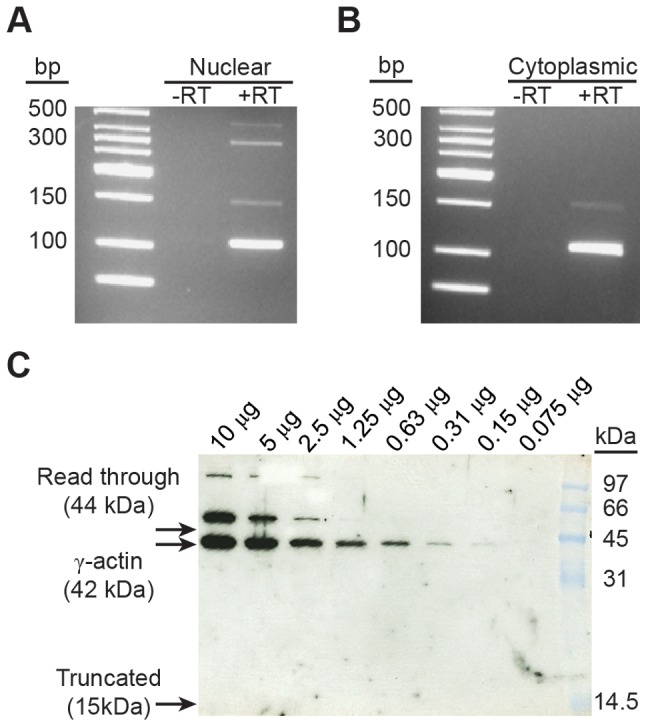
Exon 3a containing alternatively spliced Actg1 is exported to the cytoplasm, but does not produce a stable protein.Nuclear (A) and cytoplasmic (B) RNA fractions were harvested from C2C12 myotubes and evaluated for the presence of alternative Actg1 using competitive, end-point PCR. All Actg1 spliceforms, including partially spliced transcripts, were present in the nuclear fraction, however, only the normal and exon 3a transcripts were observed in the cytoplasmic fraction. (C) Western blot using an anti-γ-actin specific antibody was used to probe mouse skeletal muscle lysate for the presence of a protein product corresponding to the inclusion of exon 3a. Usage of the in-frame stop codon in exon 3a would generate a 15 kDa protein. Alternatively, read-through of the stop codon would increase the size of the ACTG1 protein by 2 kDa, resulting in a 44 kDa protein. Neither of these protein products is present. A γ-actin protein at 52 kDa is observed and likely represents a post-translational modification. Molecular weight marker is prestained Low Range (BioRad).